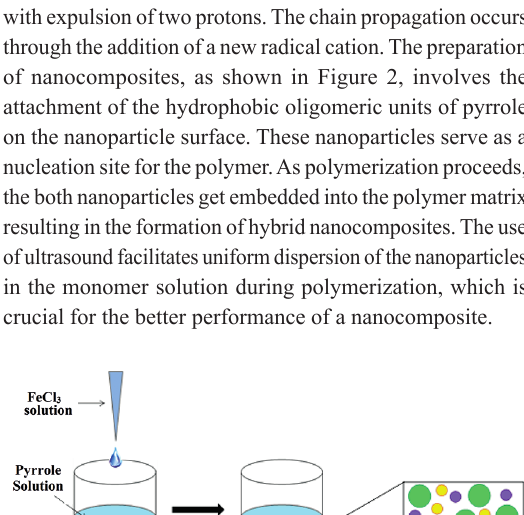
Figure 2. Chemical oxidative polymerization of PPy/(Ag hybrid